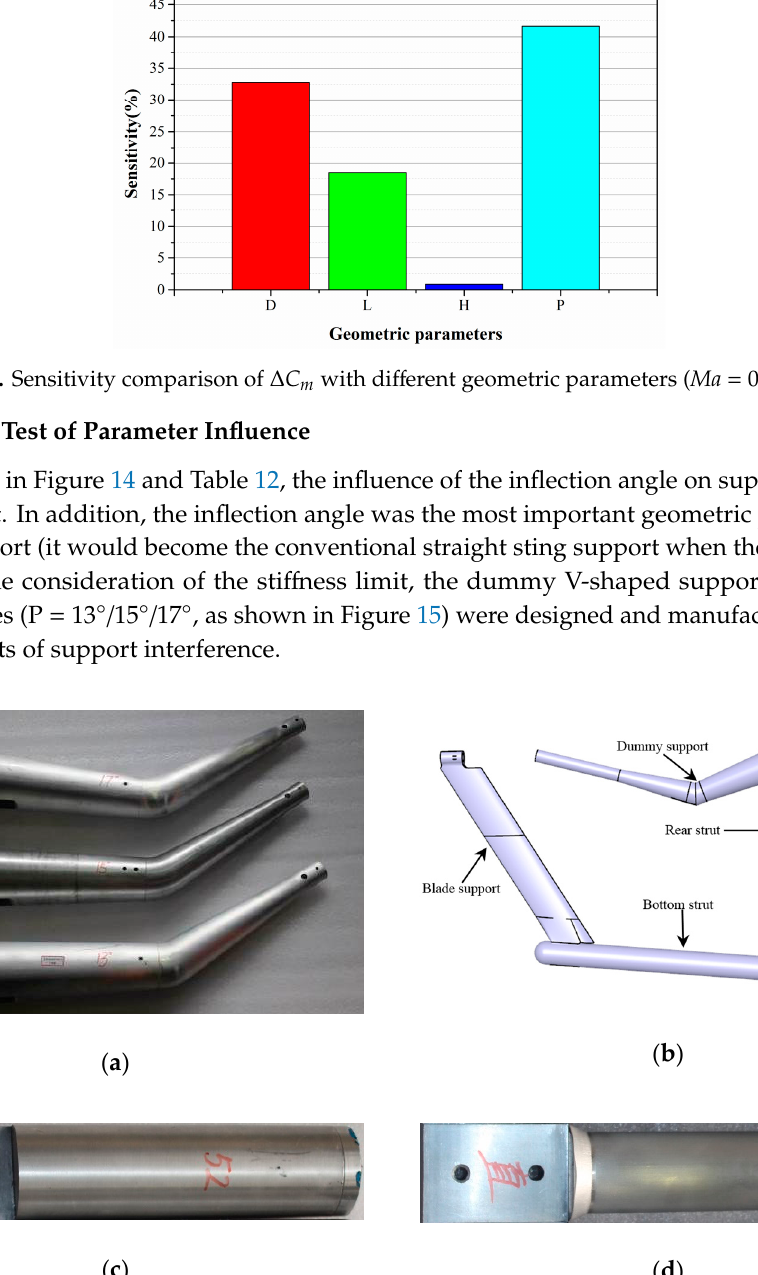
( b ) ( c ) Figure 12. Support interference results of the BWB aircraft with different inflection angles (P = 13°/15°/17°/20°, Ma = 0.75): ( a ) C L - α curves; ( b ) C D - α curves; ( c ) C m - α curves. ( a ) ( b ) Figure 13. Pressure contour and distribution of the BWB aircraft with different inflection angles (P = 13°/15°/17°/20°, Ma = 0.75, α = 0°): ( a ) pressure contour of the BWB aircraft under the P = 13° condition;